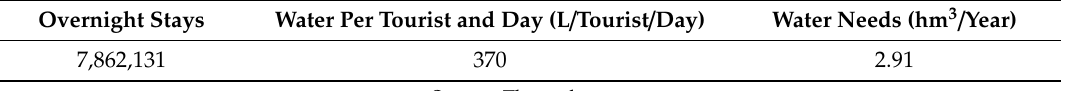
Table 6. Estimation of the volume of water used in connection with tourism, 2015.